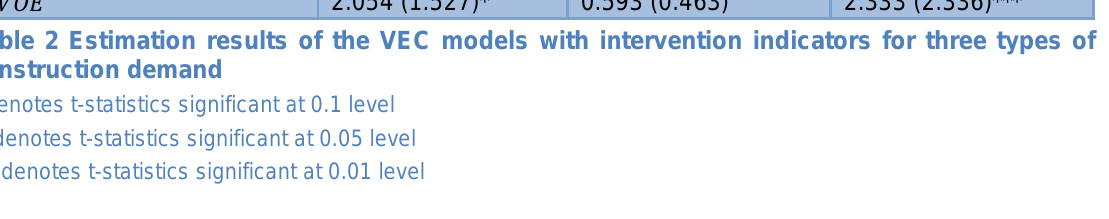
Table 2 Estimation results of the VEC models with intervention indicators for three types of construction